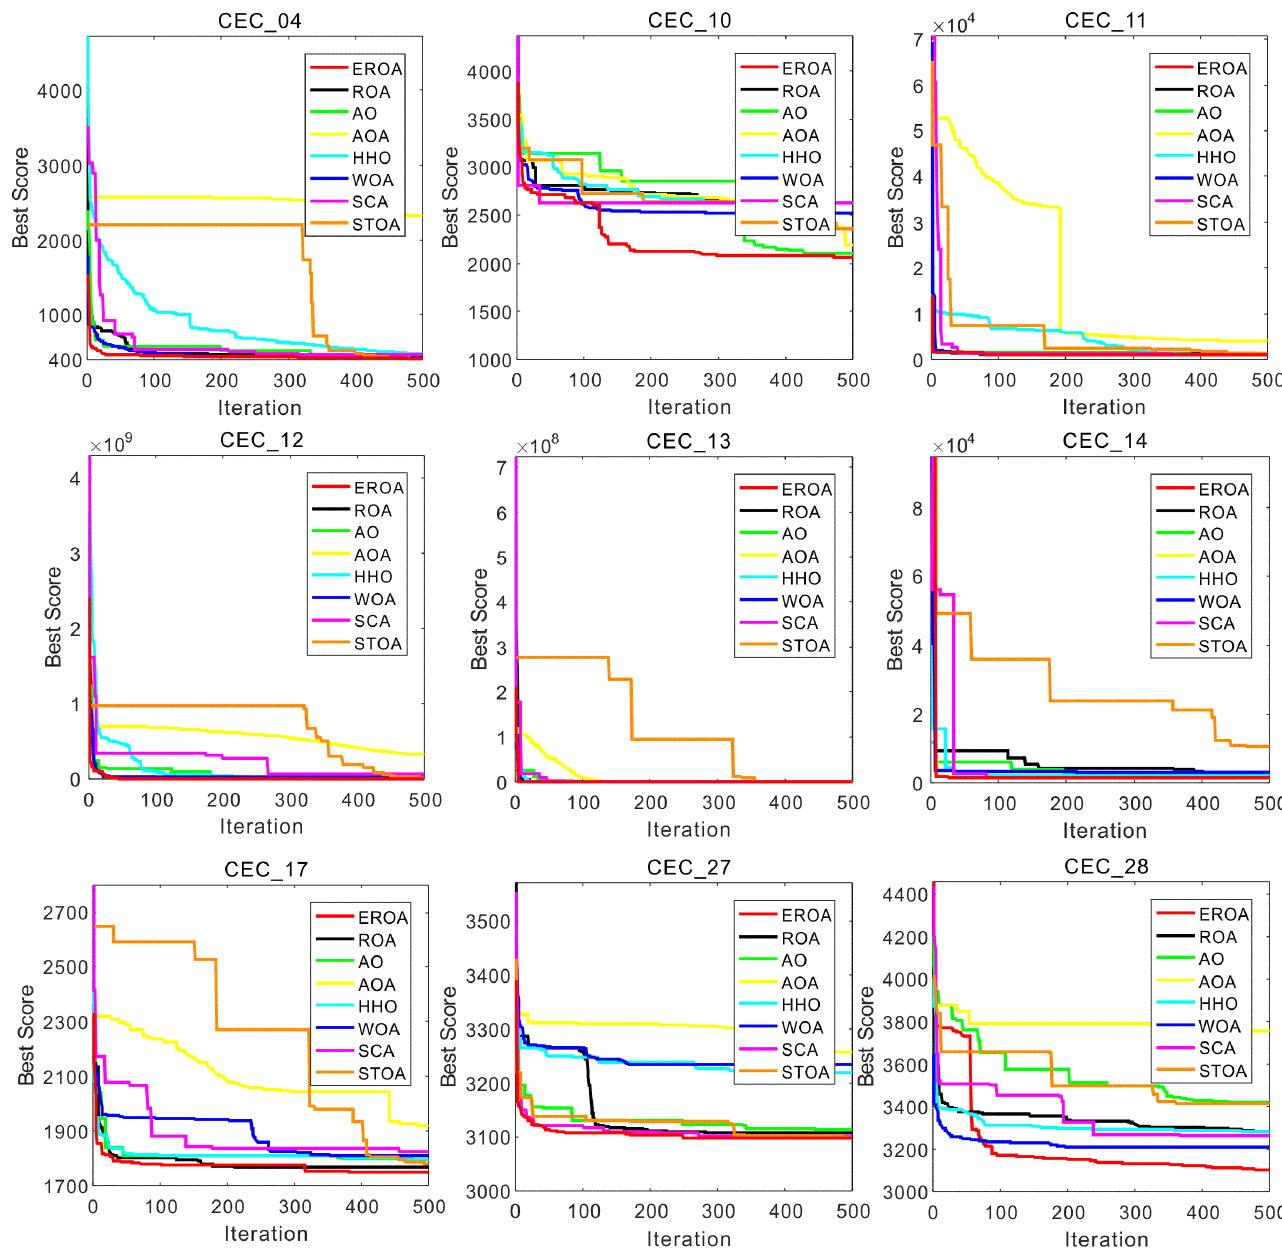
Figure 6. Convergence curves for the optimization algorithms for some test functions on CEC 2017.